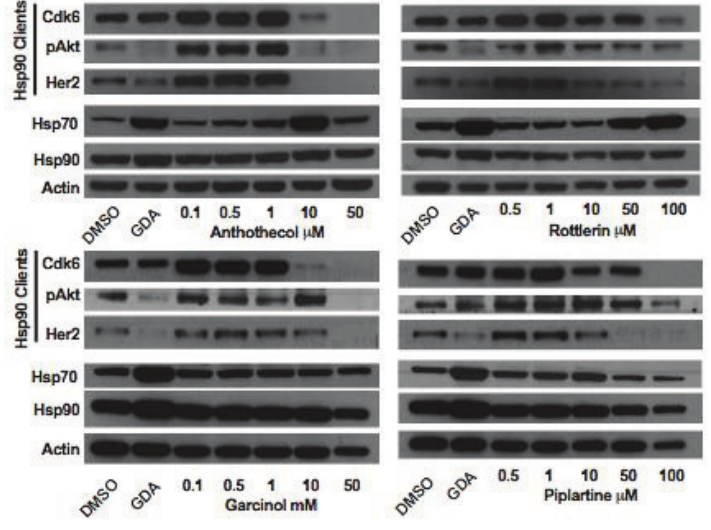
Figure 14. Western blot for Hsp90-dependent client proteins (Cdk2, pAkt and Her2),